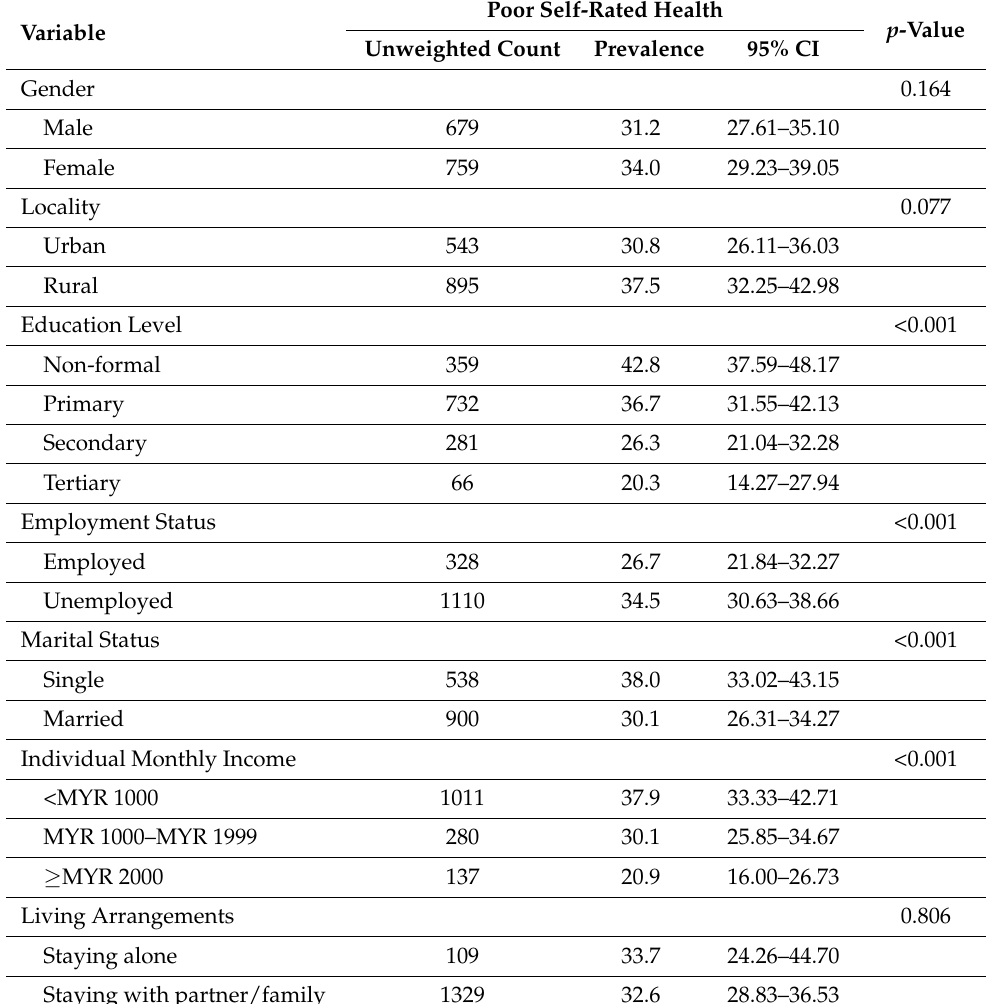
Table 2. Prevalence of poor self-rated health among Malaysian older persons aged 60 years above (n